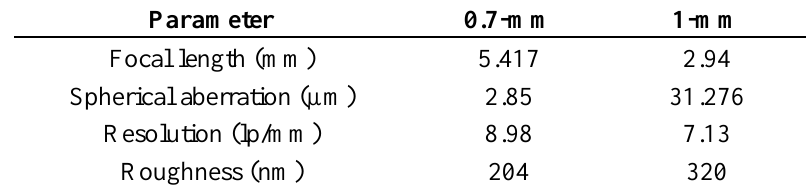
Table 1. Optical properties of PDMS microlenses with different sized apertures.